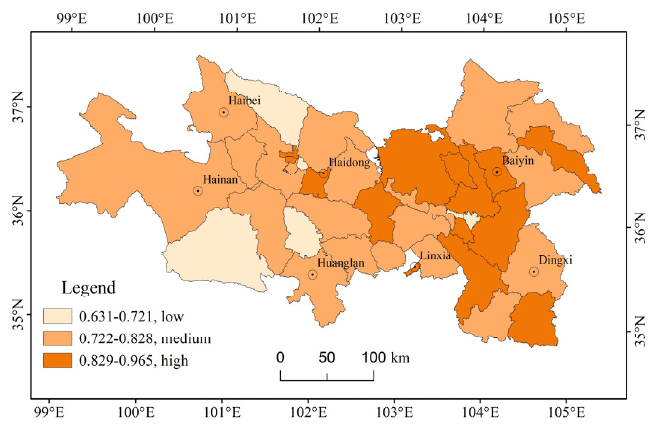
Figure 9. Classification of coupling degrees.